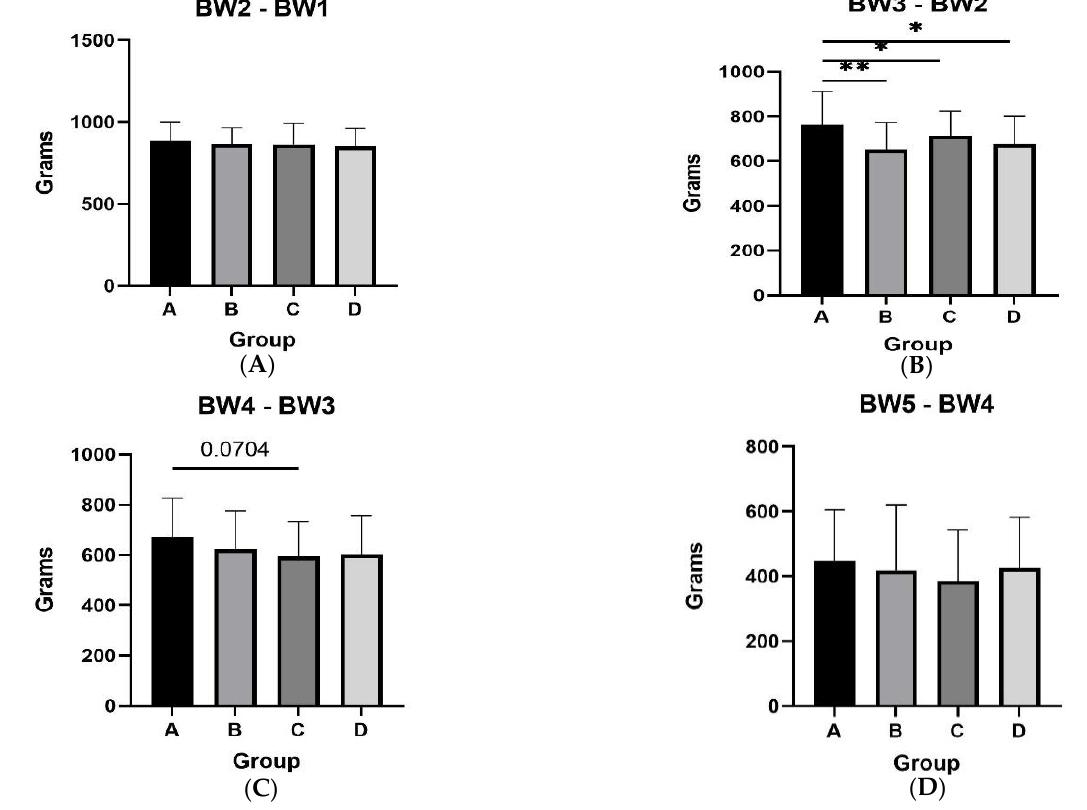
Figure 3. Body weight differences for male mink. Weight differences for male mink from the four experimental groups for the following intervals: at second month of the experimental period and at first month ( panel A ); at third month of the experimental period and at second month ( panel B ); at fourth month of the experimental period and at third month ( panel C ); at fifth month of the experimental period and at fourth month ( panel D ).* p ≤ 0.05; **: p < 0.01. Table 3. Descriptive statistics for body weights of male mink (mean and standard deviation) for the whole experimental period ( n = 25 per group).